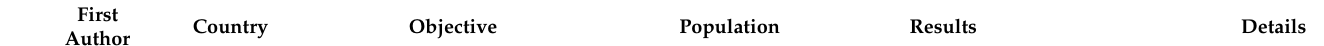
Table 5. Association of micronutrient levels/supplementation with COVID-19 illness